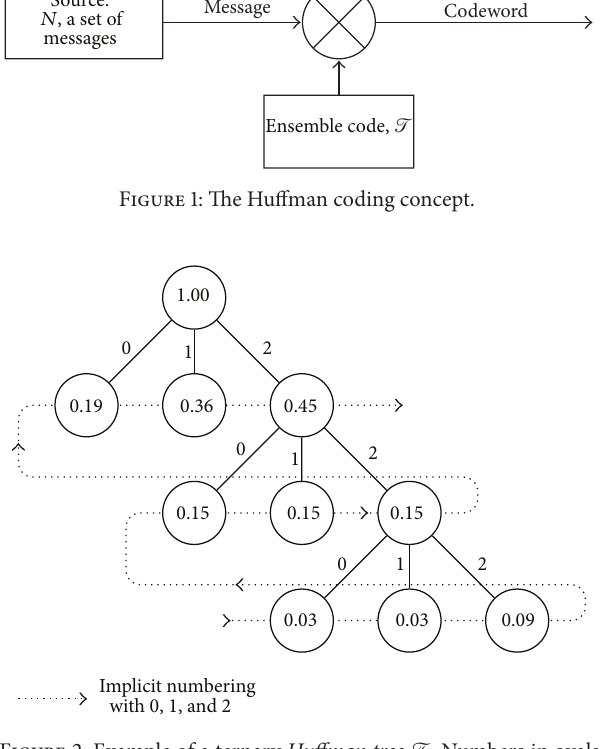
Figure 2: Example of a ternary Huffman tree T . Numbers in ovals represent